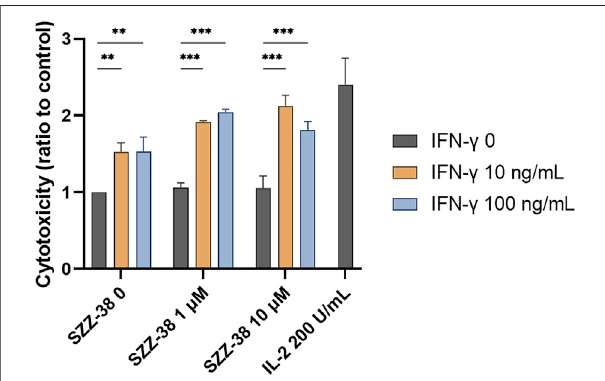
FIGURE8| Theconcentration-dependent effect ofNOD1agonist/IFN- γ combinations on the induction of PBMC cytotoxicity against K562 cells. PBMCs were treated for 18 h with SZZ-38 (1 and 10 µM), IFN- γ (10 and 100 ng/mL), their combinations, or IL-2 (200 IU/mL) before the addition ofK562cells.Cytotoxicitywasdeterminedafter4 hofco-incubation.Dataare shown relative to the negative control (0.1% DMSO) and expressed as means ± SEM of three independent experiments. Statistical signi fi cance was determined by two-way ANOVA followed by Dunnet ’ s multiple comparisons test; **, p < 0.01, ***, p <